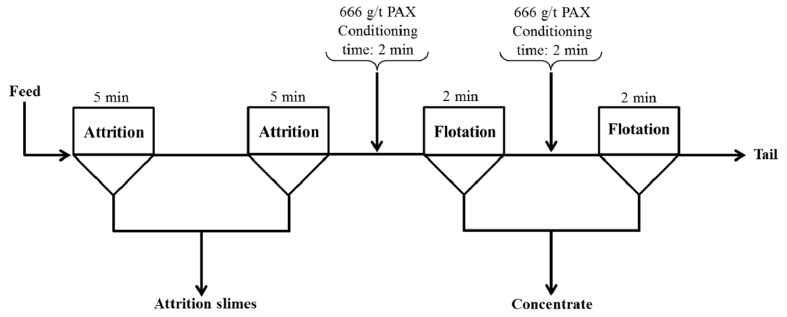
Figure 9. A schematic flow diagram for attritioning and Flotation Test‒3.